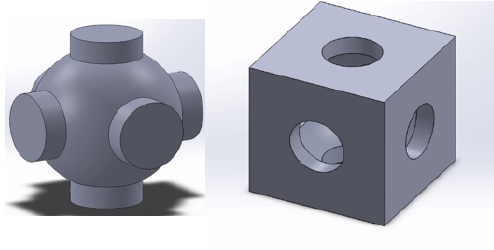
Figure 2. Benchmark DENORMS unit cell